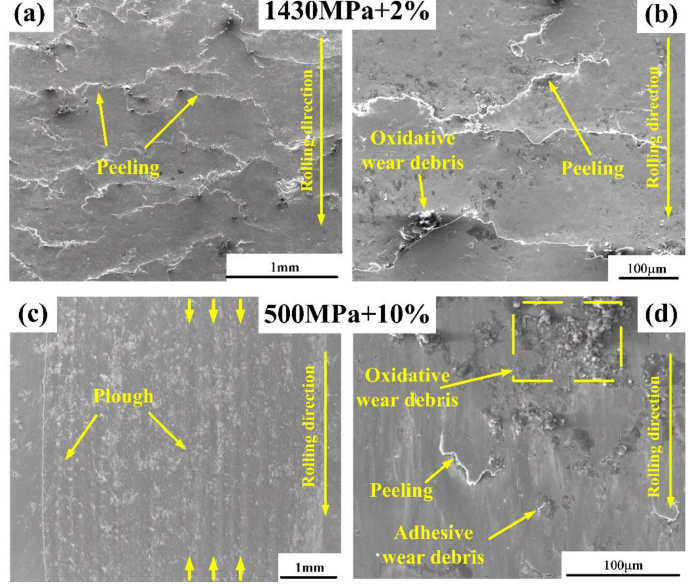
Figure 7. The surface damage morphologies of bainitic steel in SEM after tests under di ff erent wear parameters: ( a , b ) 1430 MPa + 2%; ( c , d ) 500 MPa +